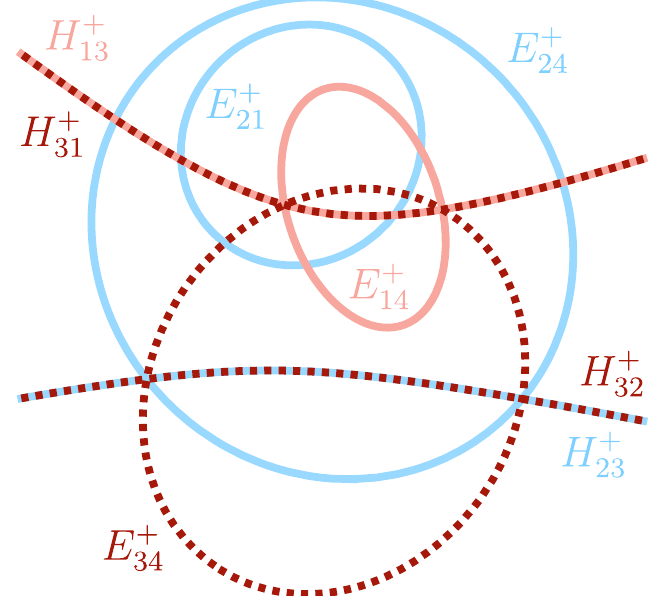
Figure 5. The singular surfaces of a box integral in two-dimensional spatial momentum space. The dual integrand R has poles on the surfaces E + and H + , R has poles on E + , E + and 1 + 2 + 14 13 21 24 , and R on E + , H + = − H + and H + = − H + . For this particular configuration, the H + 3 + 23 34 31 13 32 23 dual integrand R has no poles. First, we observe that H-surfaces appear pairwise. They locally 4 + cancel between the dual integrands. Secondly, we see that an intersection between an E- and an H-surface of the same dual integrand is identical to the one between two E-surfaces of different dual intagrands. Here, E + = E + and E + = E + . This implies that ∩ H + ∩ E + ∩ H + ∩ E + 14 13 14 34 24 23 24 34 all higher-order poles of dual integrands are E-surface intersections, which is why all poles of E- surfaces residue can be locally cancelled between E-surface (and not H-surface) residues only. The remaining intersections of E- and H-surfaces are irrelevant as they do not correspond higher-order poles in the dual integrands and therefore do not introduce poles to E-surface